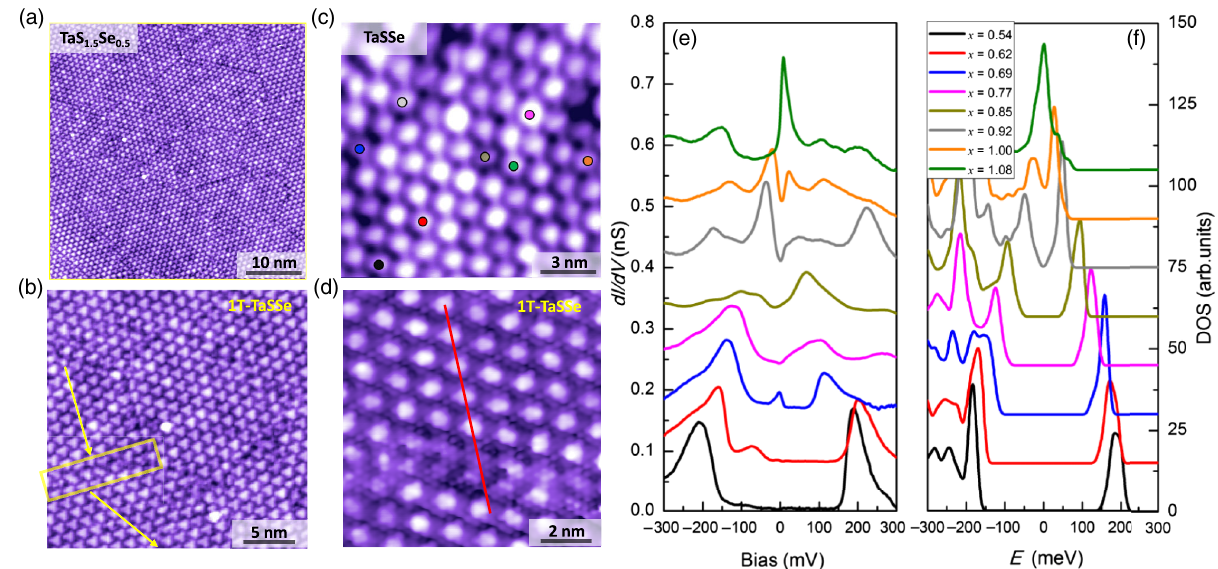
¼ − 500 mV b ¼ 0 . 5 and (b) – (d) x ¼ 1 . (e) Local STM dI=dV